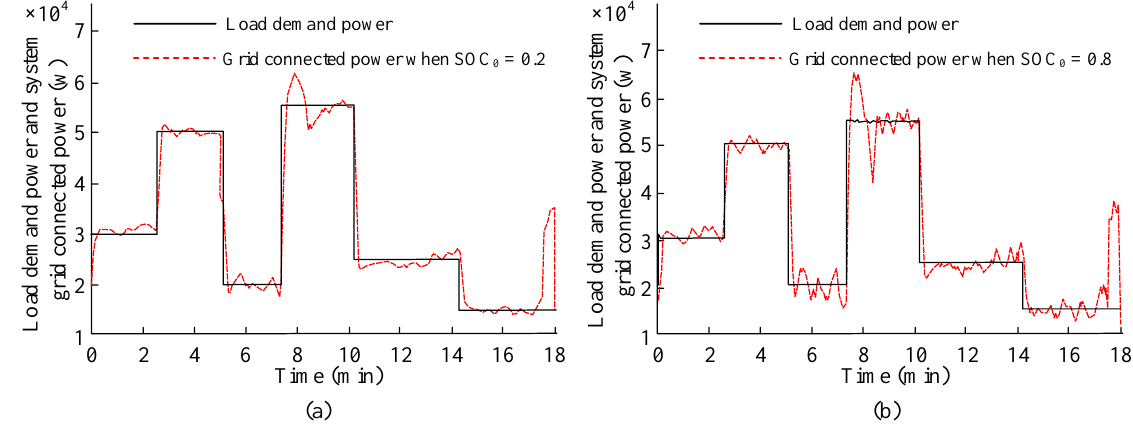
Figure 7. Grid connection of hydrogen energy storage under different conditions.